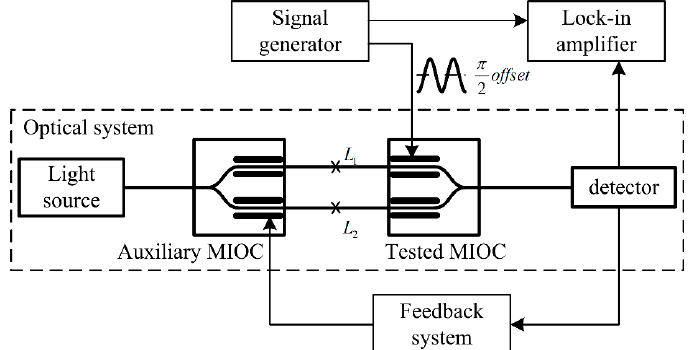
Figure 2. Schematic of the measurement method for frequency dependence of the multifunction integrated optical chip (MIOC) halfwave voltage.